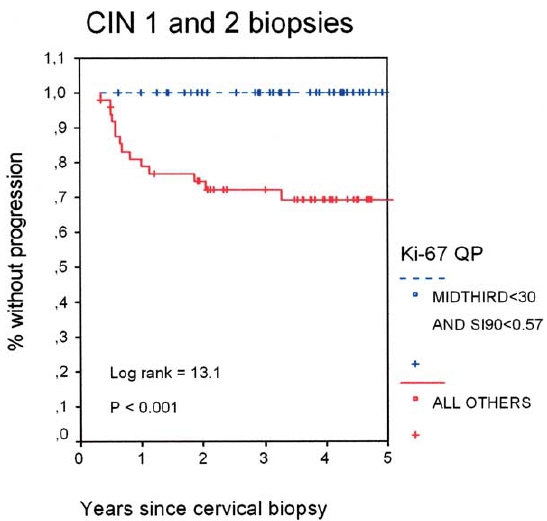
Fig. 3. Kaplan–Meier curve of the percentage of patients without progression for the low-risk (blue dotted line) and high-risk patients (red continuous line) according to the Ki67 progression-risk model (Ki67 QP).